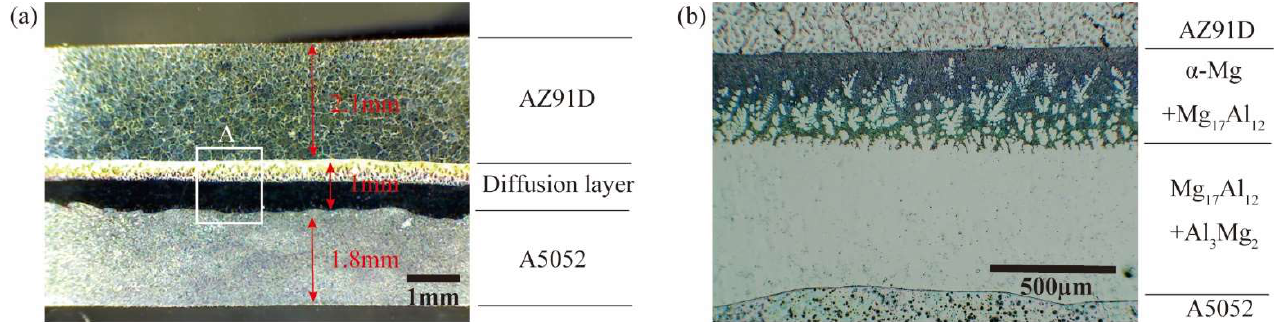
Figure 9. ( a ) Cross-section of the AZ91D/A5052 clad strips cast by the horizontal twin-roll caster; ( b ) microstructure of region A of the bonding interface in ( a ).